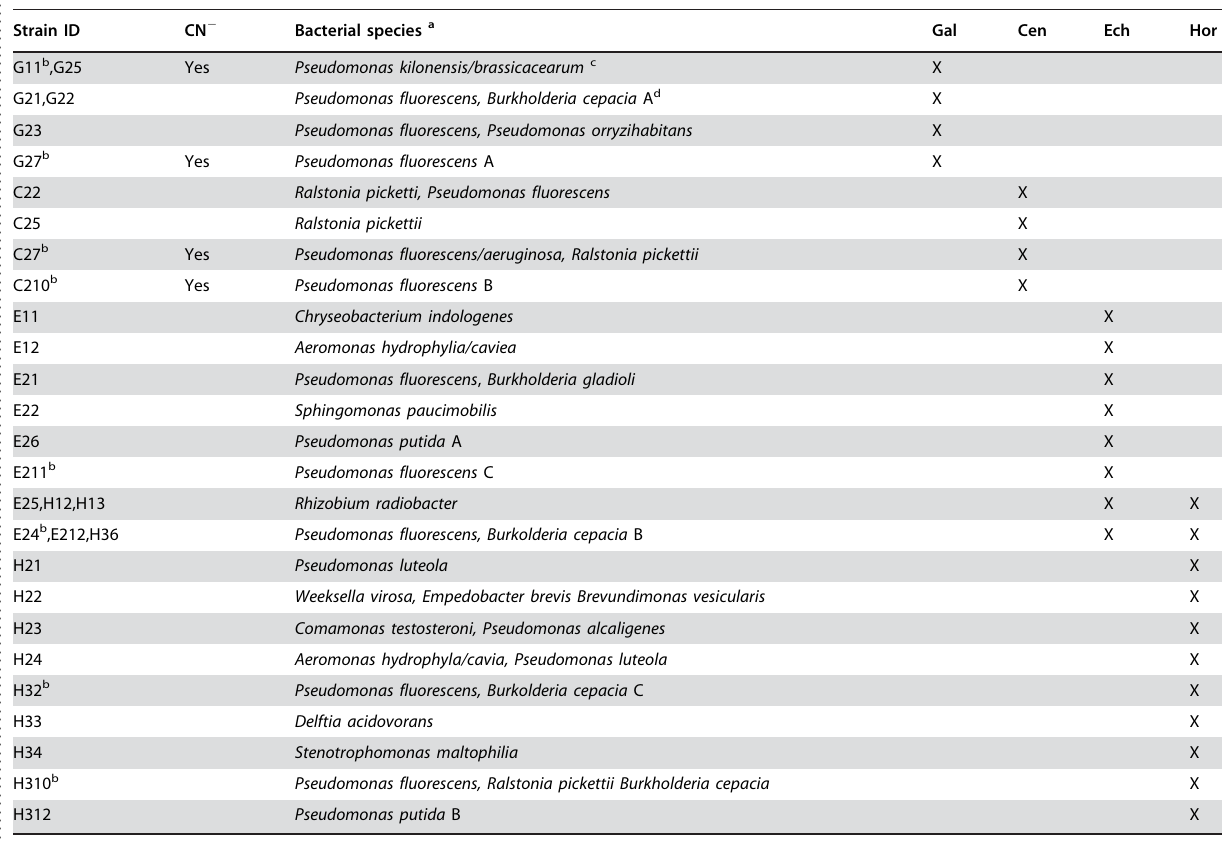
Table 1. Rhizobacterial communities of four weedy plant species. .. ... .... ... ... .... ... ... .... ... ... .... ... ... .... ... ... .... ... ... .... ... ... .... ... ... .... ... ... .... ... ... .... ... ... .... ... ... .... ... ... .... ... ... .